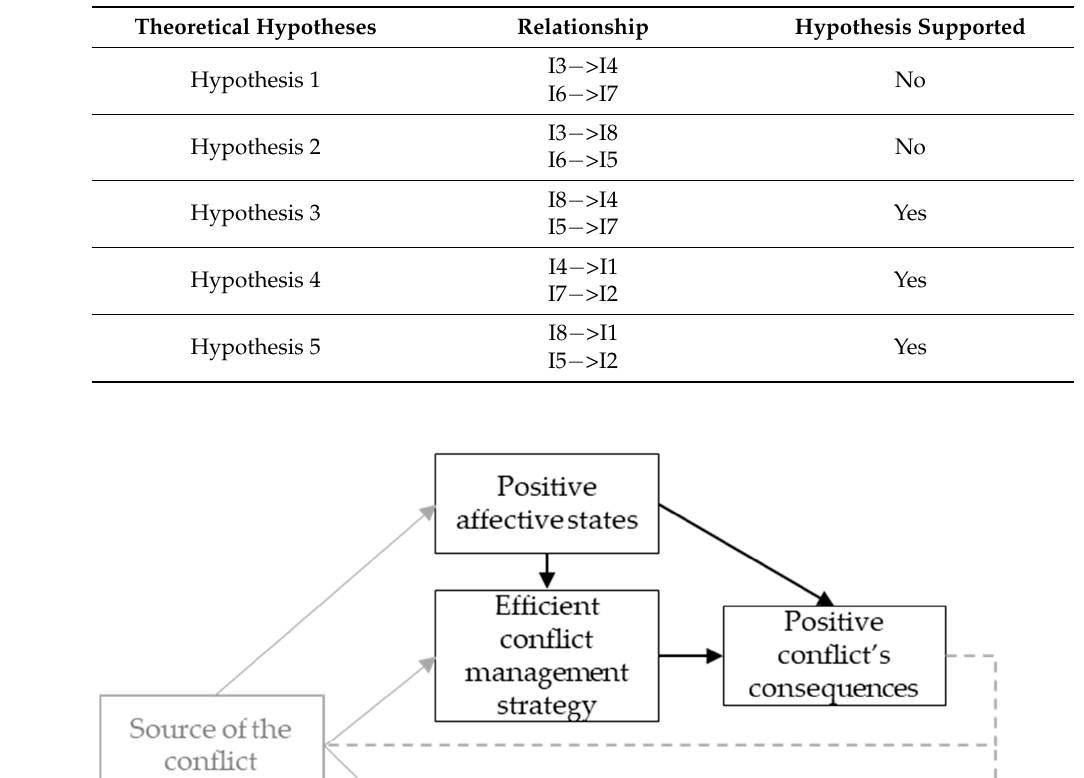
Table 7. Hypotheses systematization.